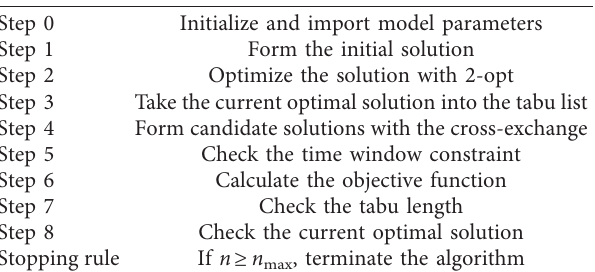
Table 1: Simplified algorithm flow